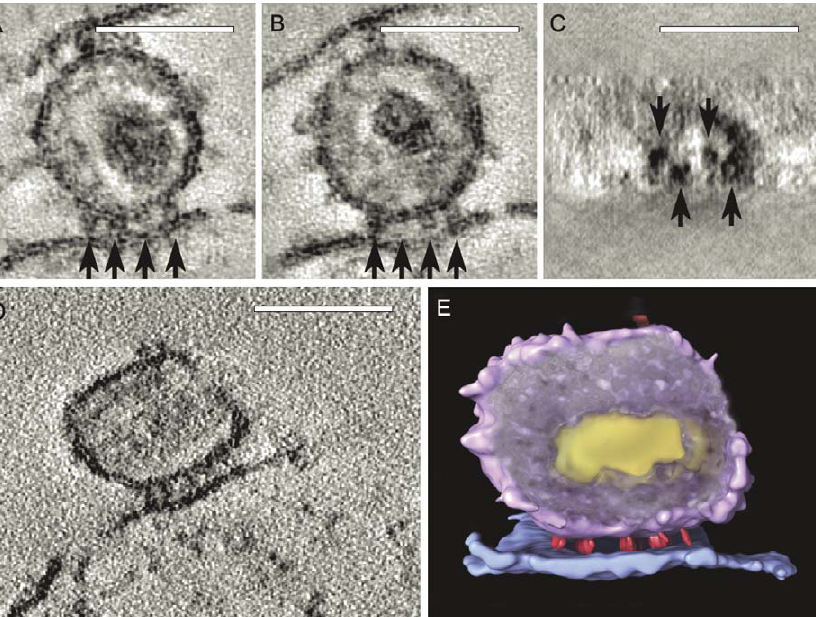
Figure 5. Electron Tomography of Virus–Cell Contact in Chronically and Acutely Infected Cells (A–C) Single 1-nm slices extracted from a dual axis tomogram reconstructed by weighted back-projection where part of an entry claw is captured in a chronically infected cell. One combination of three rods can be seen in one plane (A), while a different combination of three rods can be seen in the other (B). Four of the rods can be seen clearly in orthogonal view sectioned close to the plane of contact between virus and cell (C), with the densities arranged in a zig-zag manner. The black arrows point to the four densities in both transverse and top views. (D) A 1-nm tomographic slice from SIV–T cell contact region in cells fixed 15 min after warming to 37 8 C following incubation with high viral concentrations. Scale bars are 100 nm long in (A–D). (E) 3-D rendering of the same contact region presented in panel (D), showing the viral envelope (magenta), contact rods (red), core (yellow), and cell membrane (blue). Note that there are almost no spikes on the virion surface away from the region of viral–cell contact.